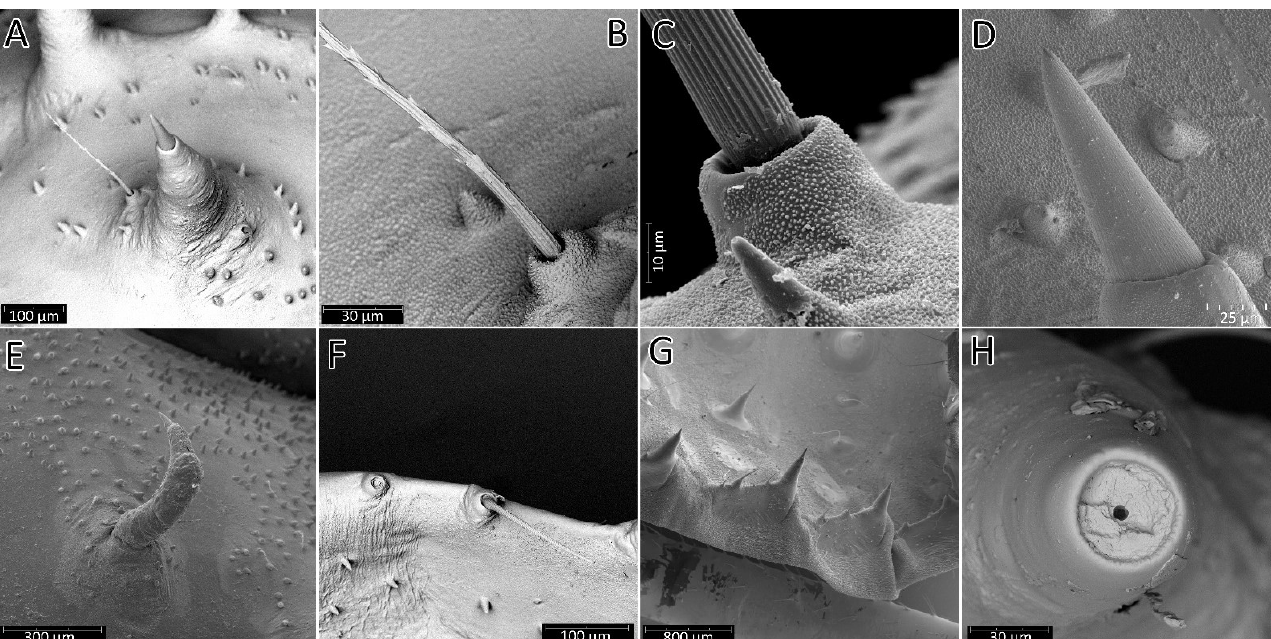
Figure 16. SEM views of the processes on the body of the instars of Psyttala horrida (Stål, 1865). ( A ) Spine-like processes accompanied by cirrous seta; ( B ) magnification of the cirrous seta; ( C ) magni- fication of the cirrous seta base with visible cuticle sculpture; ( D ) magnification of the longitudinally ribbed top of the process; ( E ) not correctly developed process; ( F ) first instar, single seta on the edge of the abdomen segment; ( G ) third instar, a field with three processes on the edge of the abdomen segment; ( H ) apical part of the process without a tip—visible pore in a hollow.